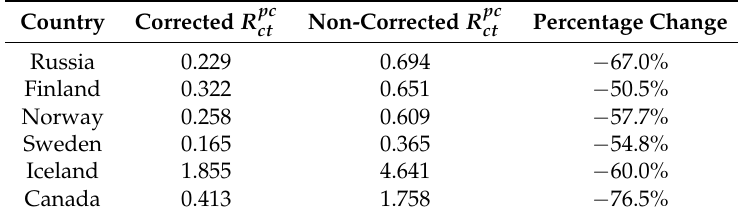
Table 1. Median sum of light in selected countries countries with and without floor correction.